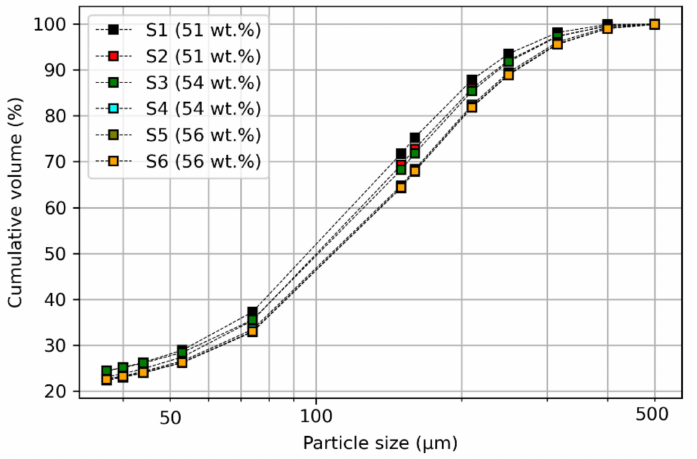
Figure 1. Cumulative particle size distribution of the concentrated phosphate slurry (CPS) samples in terms of the percentage of cumulative volume versus particle size. S1–S6 signify the sample